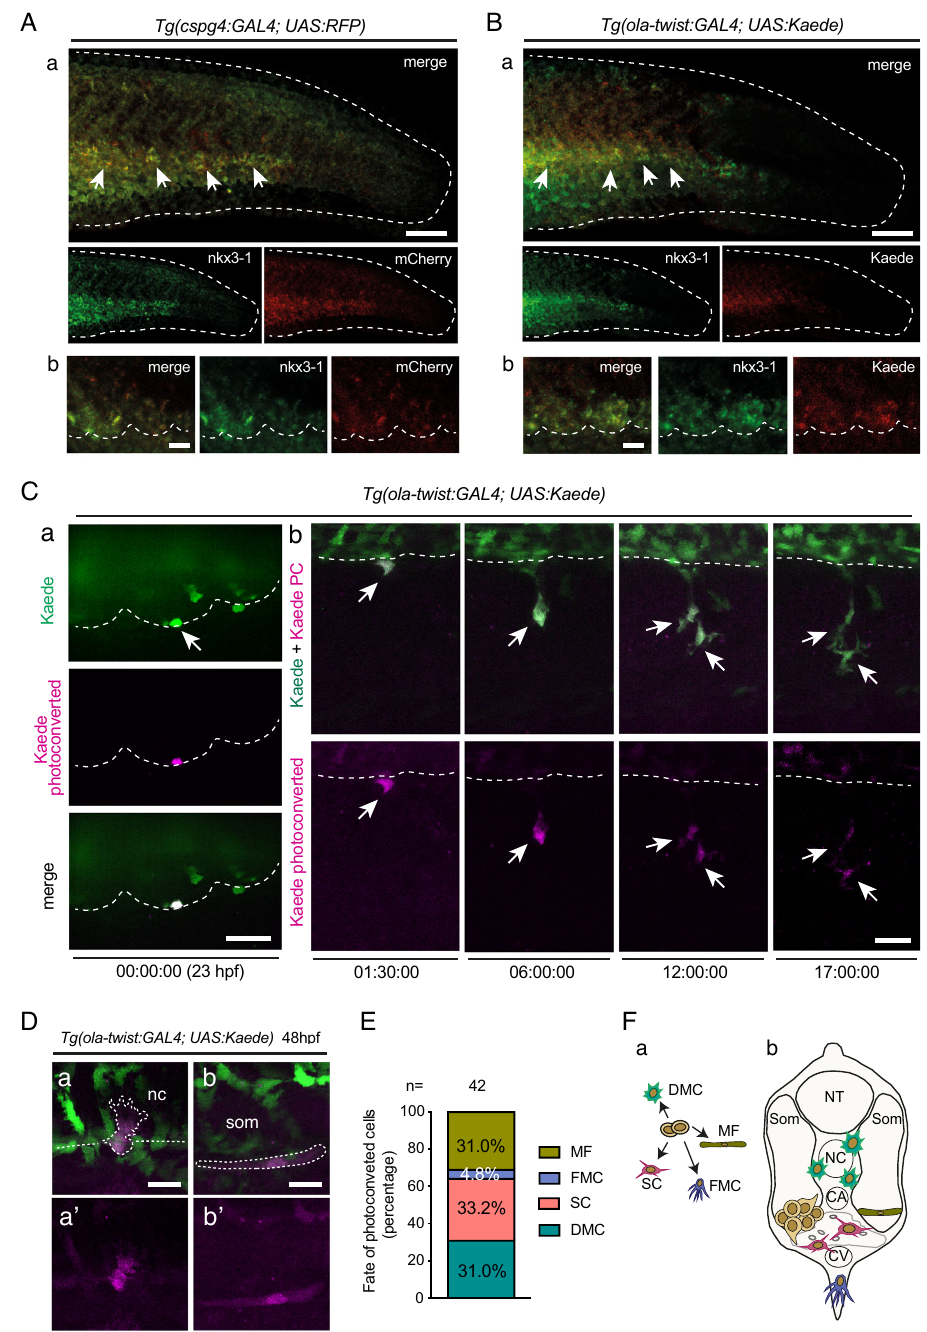
Fig. 5 | Somite VCs coincide with the sclerotome. A , B Tg(cspg4:Gal4; UAS:RFP) embryos ( A ) and Tg(ola-twist:Gal4; UAS:Kaede) embryos ( B ) were fi xed at 24 hpf andsubjectedtodouble fl uorescenceWISHusingprobesfor nkx3.1 and mCherry or Kaede mRNA,respectively.Theentiretailarea( a )andmagni fi edimagesoftheVCs ( b )areshown;dashedlineandarrowsin a indicatetheborderofthecaudalregion and VC cells showing double staining. Dashed lines in b delineate the VC ventral borders. Scale bars, 100 µ m in ( a ) and 20 µ m in ( b ). C Confocal images of a live Tg(ola-twist:Gal4; UAS:Kaede) embryo. a a single Kaede(green) + cell at the ventral border of an anterior caudal somite was photoconverted (magenta) at 23 hpf. b Representative frames from a time-lapse follow-up of the Kaede + cell photo- converted in (a), which underwent mitosis at 10h15 ( ∼ 33 hpf). Dashed line